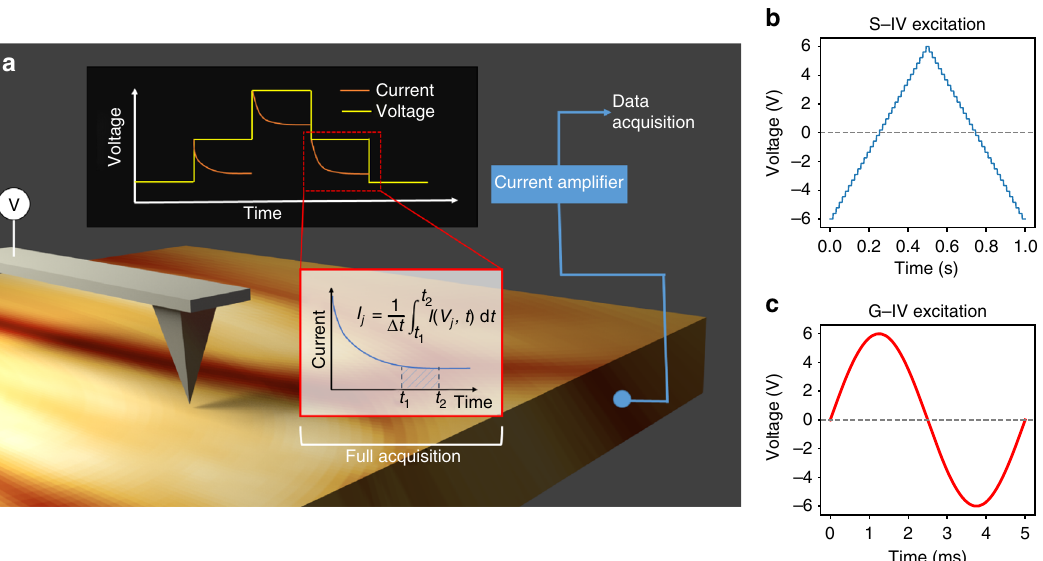
Fig. 1 Schematic for I – V measurements in contact-mode AFM. a In this schematic, the tip is biased with respect to the bottom electrode which is grounded. Current fl ows are detected and ampli fi ed by use of a high-gain current ampli fi er, with the output fed into a data acquisition system. b In an S-IV measurement, a slowly varying DC waveform is applied to the tip (or sample) and the current is measured; each step in the voltage results in a relaxation in the measured current due to the capacitance in the circuit. By neglecting some portion of this current and averaging over some integration time Δ t , a single value of the current I j at V j is recorded. In general-mode I – V , the waveform is fast (see c ) (generally, sinusoidal but not limited to this case), and the full current stream is recorded, allowing fi ltering after collection as